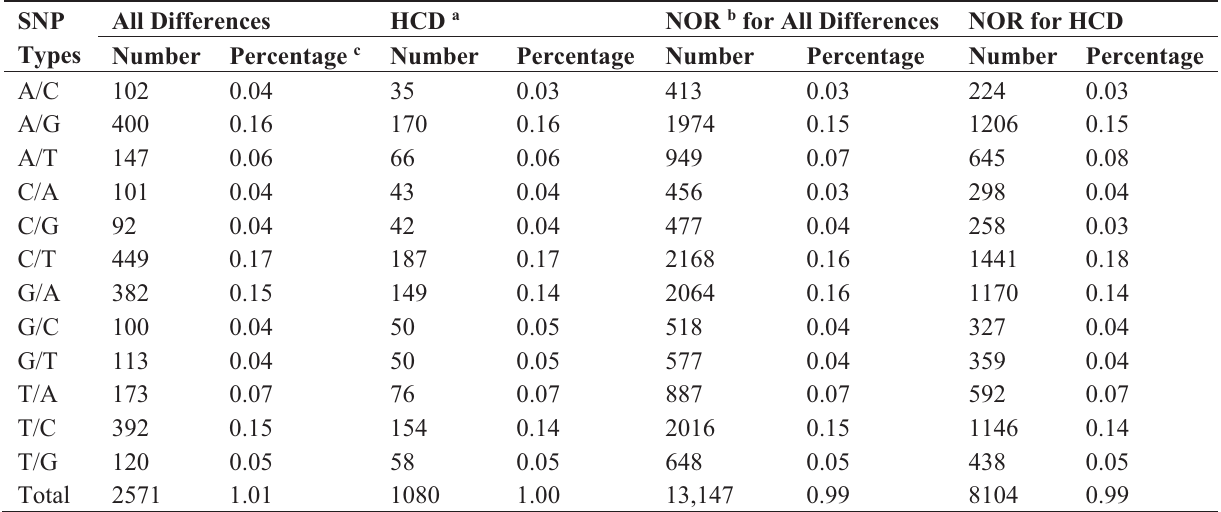
Table 4. Summary of SNPs discovered from the genome sequencer (GS) reference